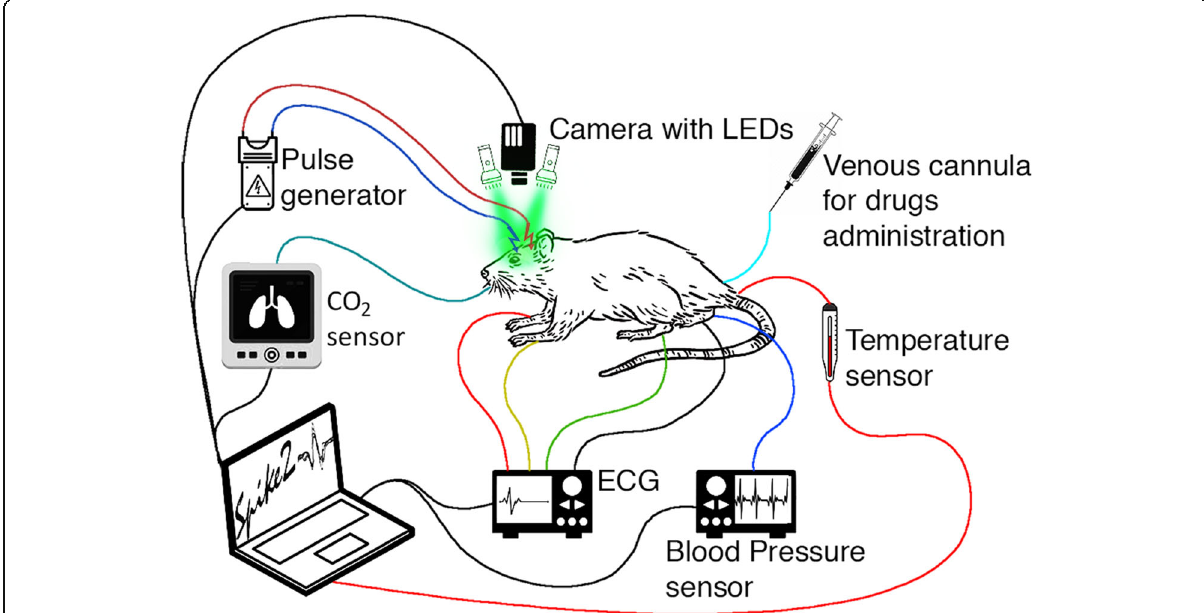
Fig. 1 Schematic diagram of the experimental setup for monitoring the meningeal-blood-flow response and key physiological parameters to CCW electrical